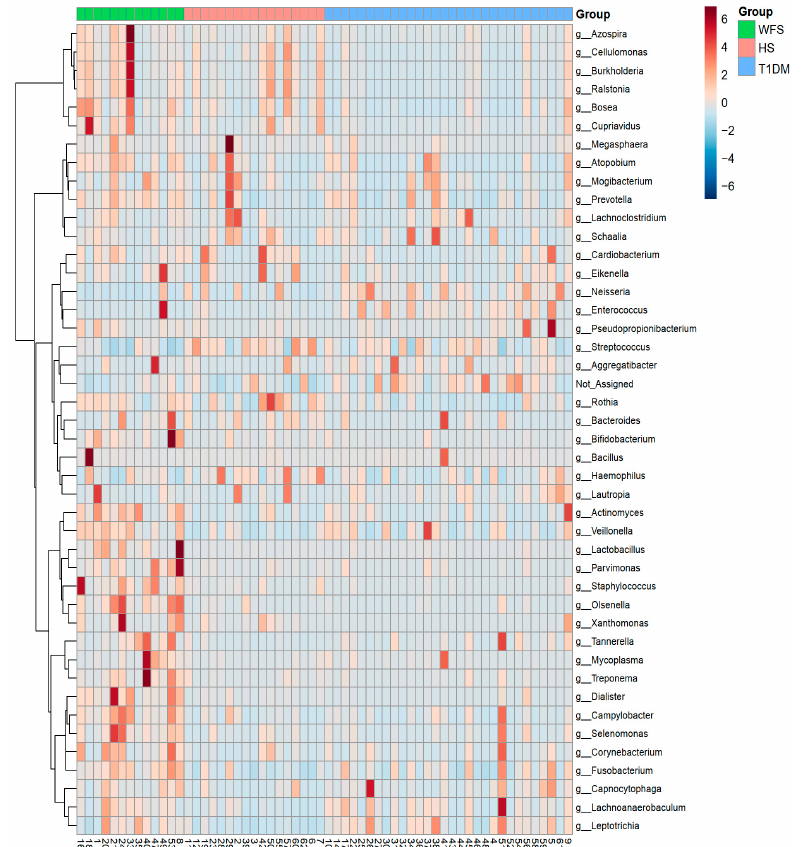
Figure 2. The result of the hierarchical clustering analysis presented as a heatmap. WFS—Wolfram syndrome; HS—healthy subjects; T1DM—Type 1 diabetes mellitus. The overall core microbiome analysis is presented in Supplementary Figure S1.